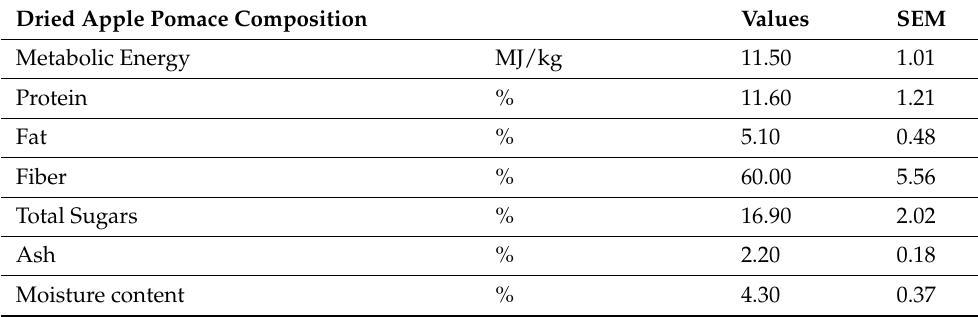
Table 5. Nutritional value of the dried apple pomace (DAP) used in the